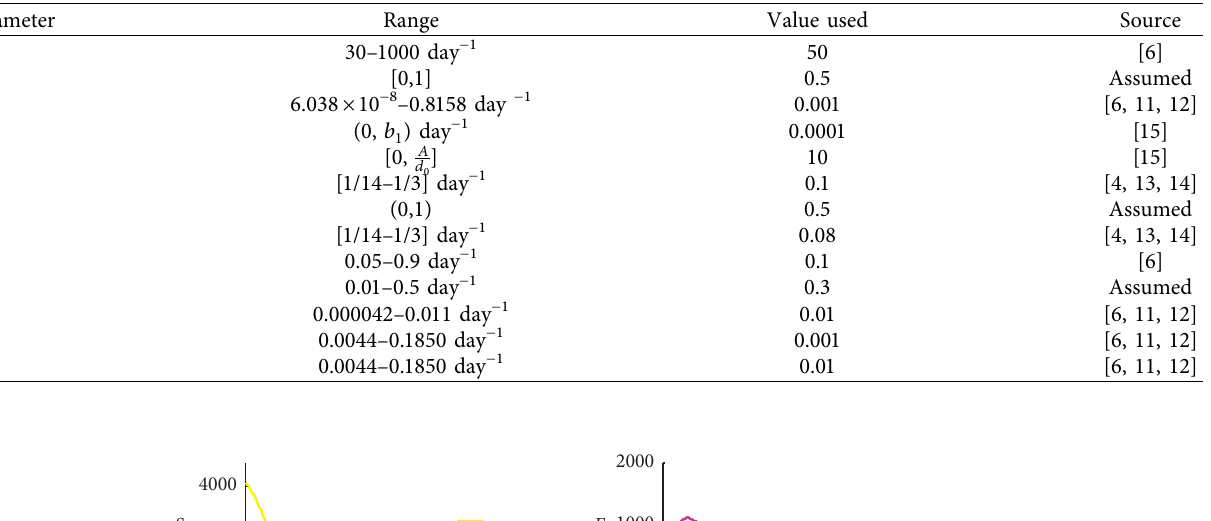
Table 2: The baseline values of the parameters of system (1).